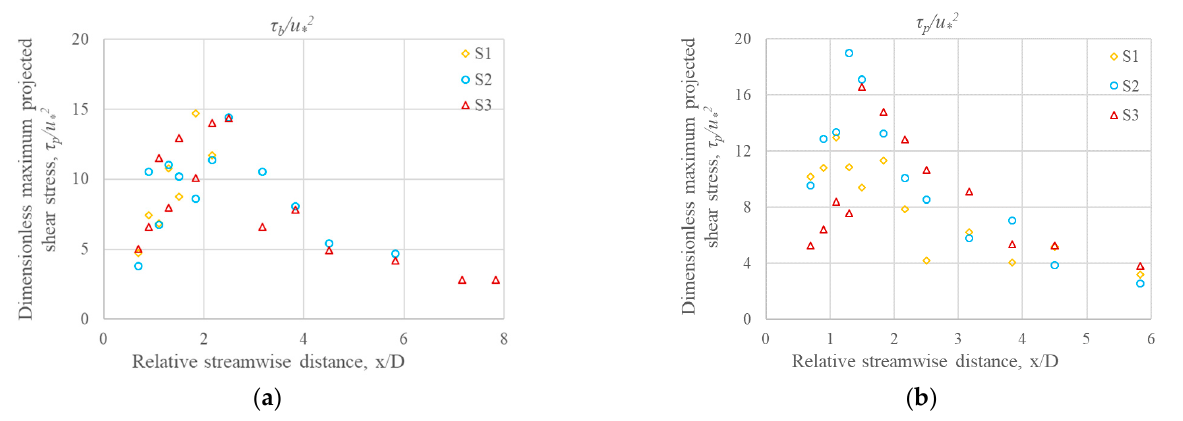
Figure 8. Variation of dimensionless maximum projected Reynolds shear stress ( τ p /u * 2 ) in the symmetry plane: ( a ) mid- stream and ( b ) downstream.